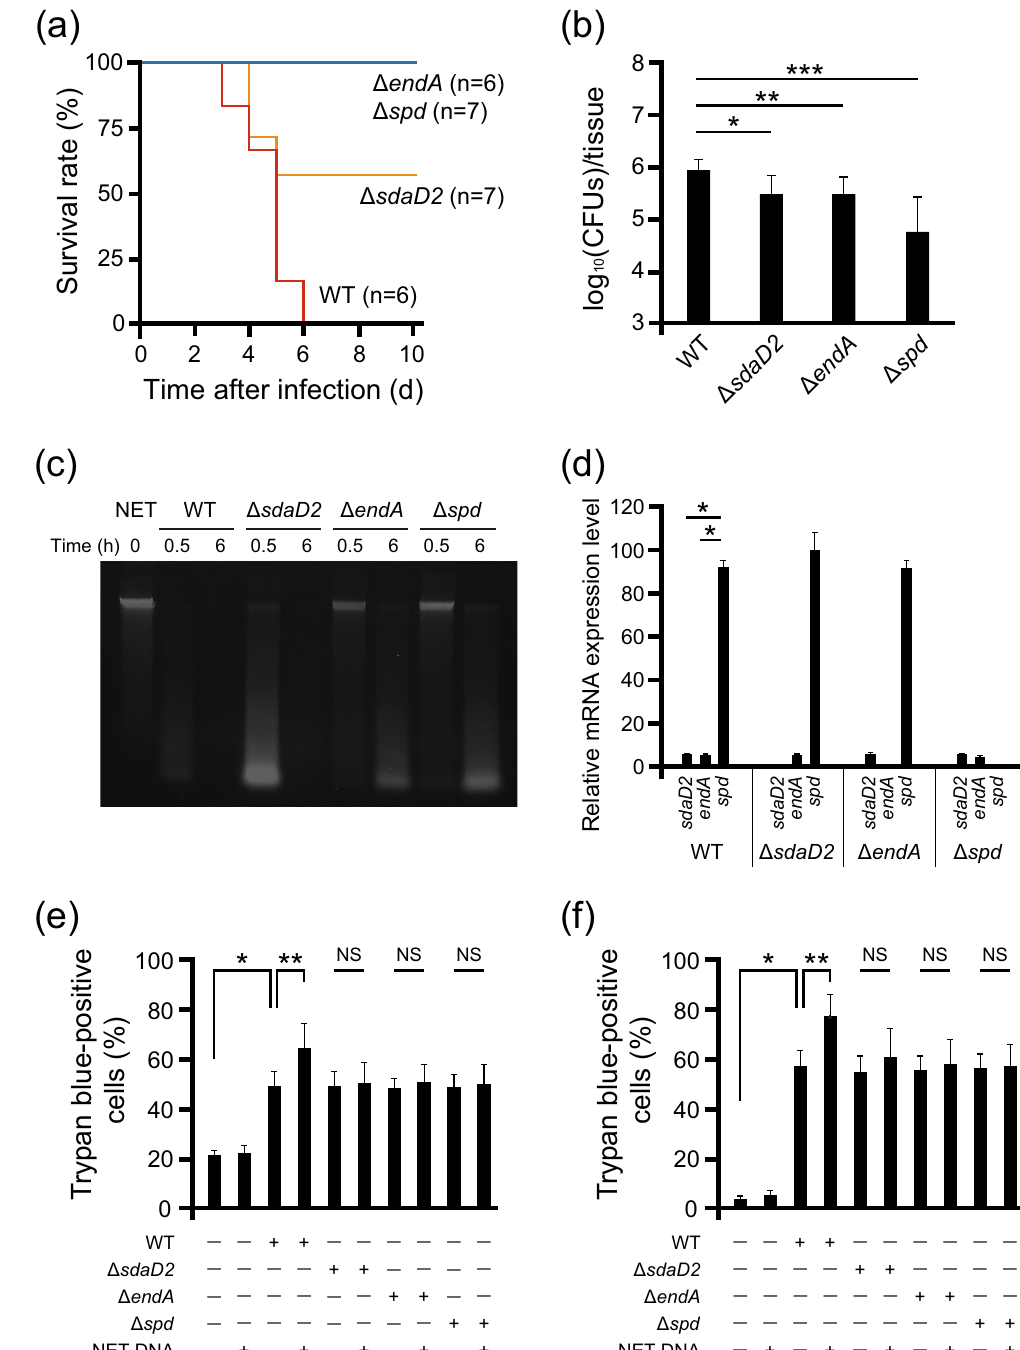
Figure 4. Essential role of DNase in GAS pharyngitis in vivo . ( a ) Survival curves of mice with nasal infection. Male C57BL/6 mice aged 6–7 weeks were intranasally infected with the wild-type (WT) or DNase knockout bacterial strains, and survival curves were generated (each group consisted of 6 or more mice). The survival curves of mice infected with DNase-knockout bacterial strains were longer than those of mice infected with the wild-type bacterial strain (Log-rank test; p < 0.01). ( b ) Comparison of the live bacterial count 18 h after infection in the maxillary sinus of mice intranasally infected with the WT, sdaD2 - knockout ( Δ sdaD2 ), endA -knockout ( Δ endA ), or spd -knockout ( Δ spd ) bacterial strains. The bar indicates the geometric mean. * p = 0.059, ** p = 0.046, *** p = 0.014 (the Student’s t -test). ( c ) NETs degradation activities among the WT and DNase-deficient mutants using agarose gel electrophoresis. ( d ) Quantification of mRNA for DNases by real-time PCR in WT and DNase-deficient mutants. ( e ) The supernatant of the WT and DNase-deficient mutants co-cultured with or without NET-DNA was added to THP-1 cells. Trypan blue-positive cells were counted at 6 h and the ratio among the total cell count was calculated. * p <